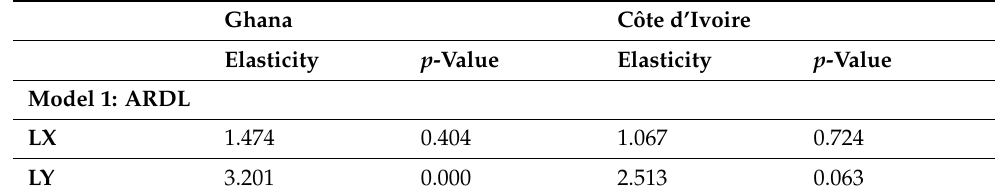
Table 3. Long-Run Turkish Cocoa Import Elasticities.